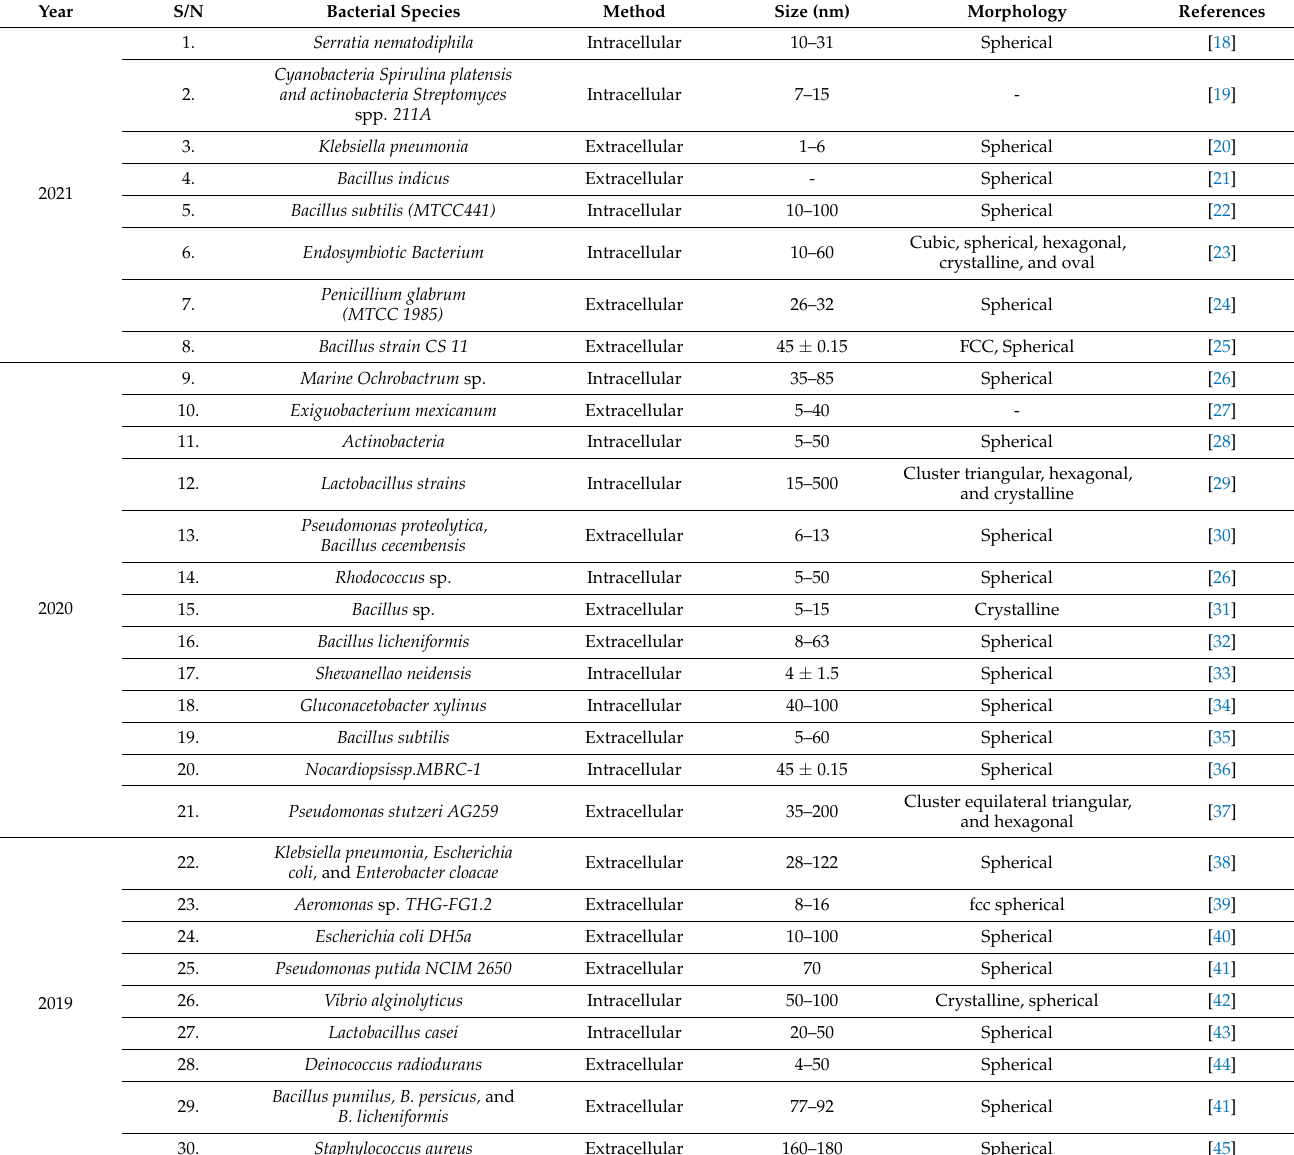
Table 1. Synthesis of AgNPs from various bacterial